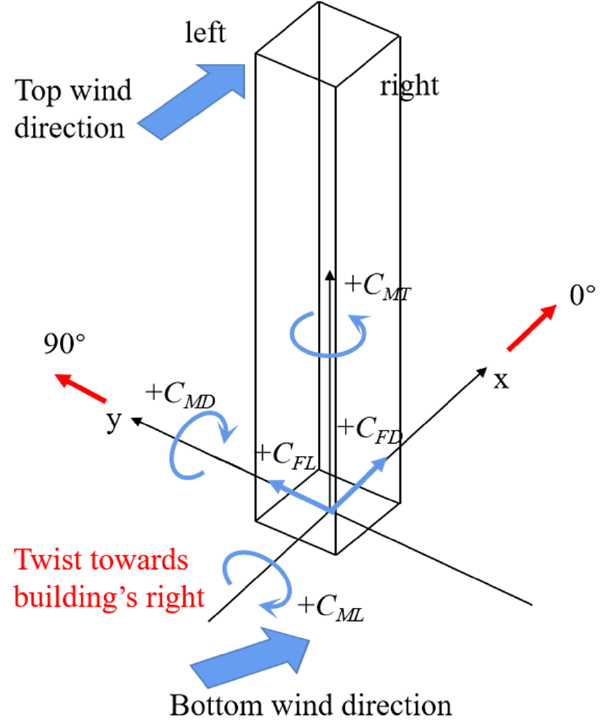
Figure 5. Definition of forces and moments applied to the